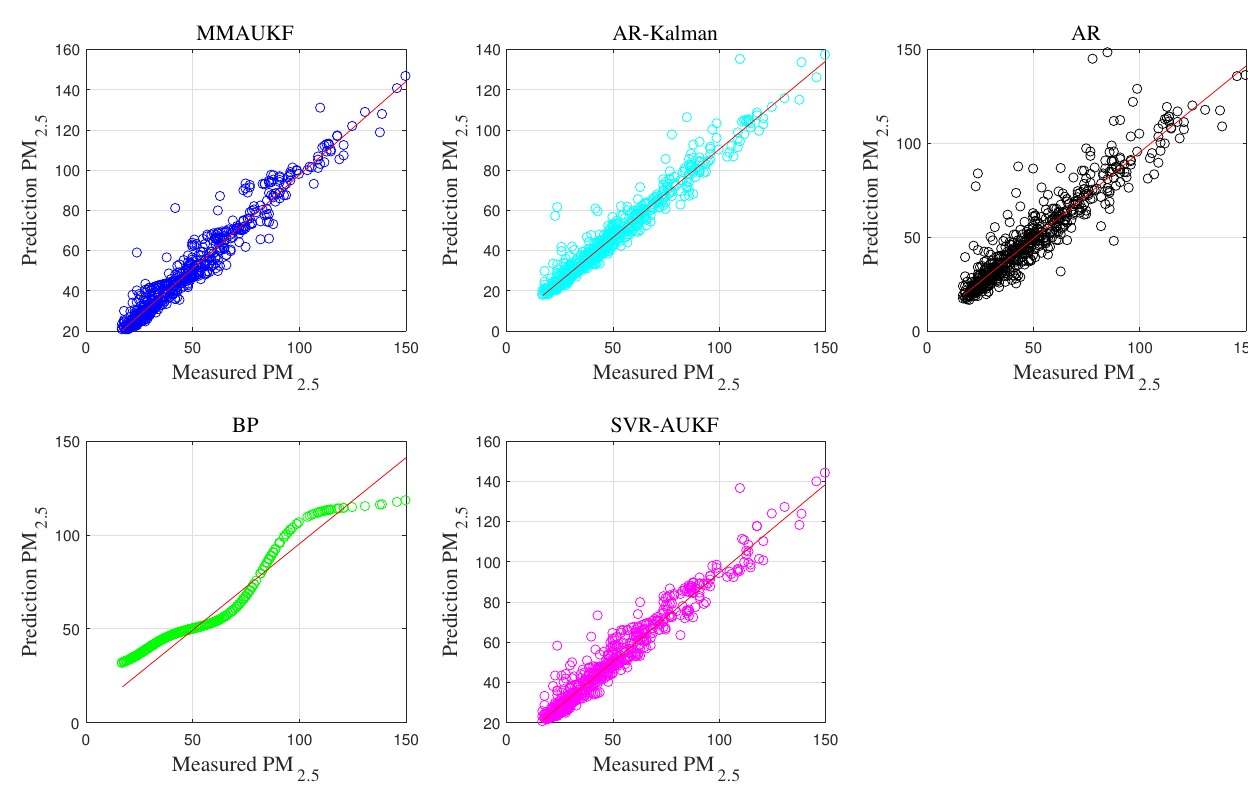
Figure 16. Boxplot of different methods’ prediction residual.